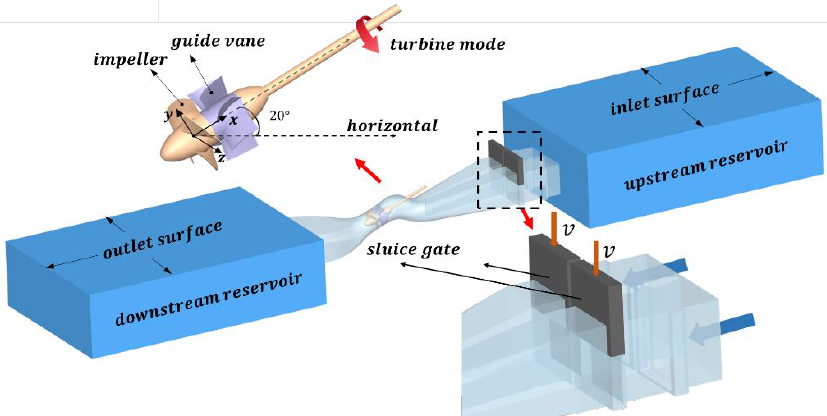
Figure 1. The schematic diagram of the pump system under shut-off conditions.